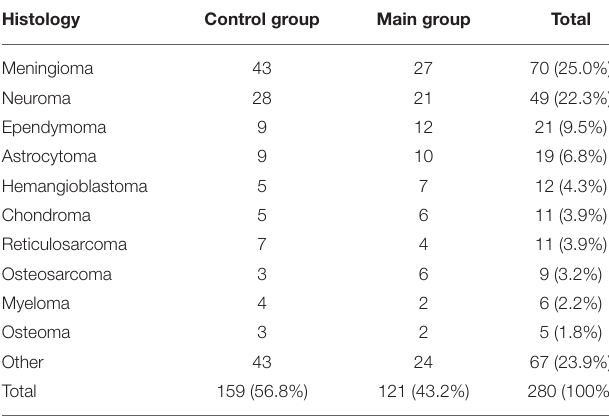
TABLE 1 | Distribution of the spinal tumors by histological